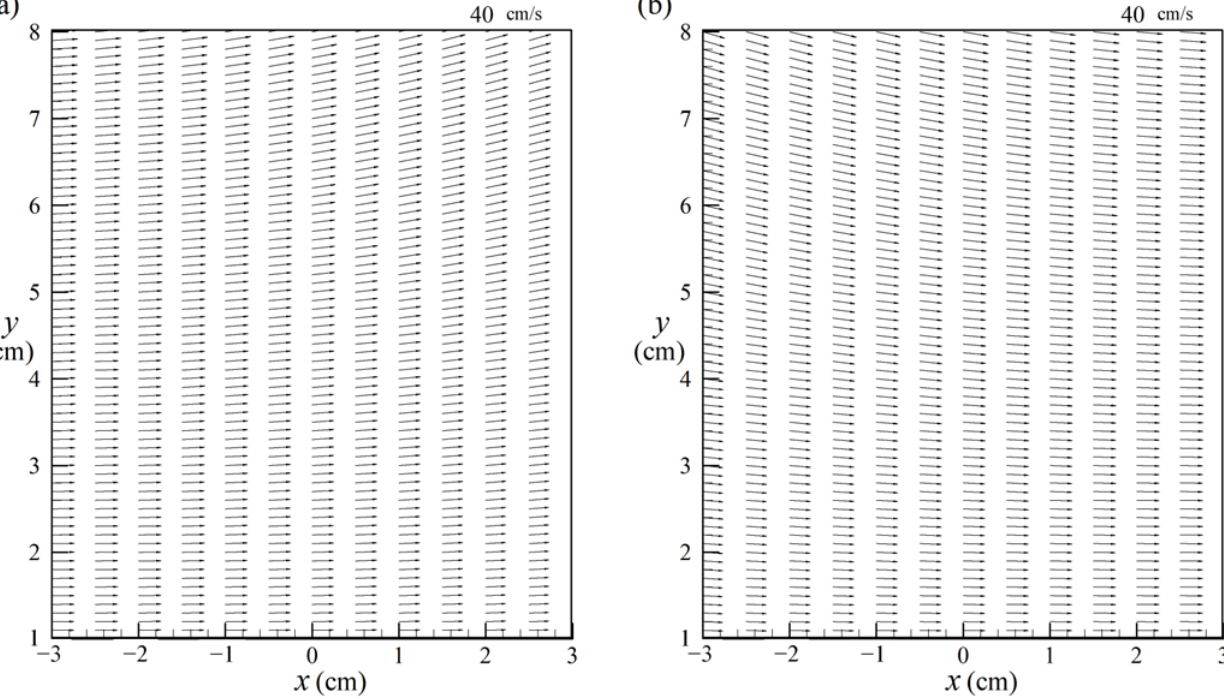
Figure 4. The (ensemble-averaged) velocity fields obtained at ( a ) t = − 0.045 s; ( b ) t = 0.045 s (Case E).